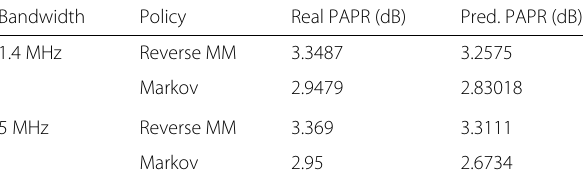
Table 2 Multiplexing-Mode LINC theoretical and real PAPR values